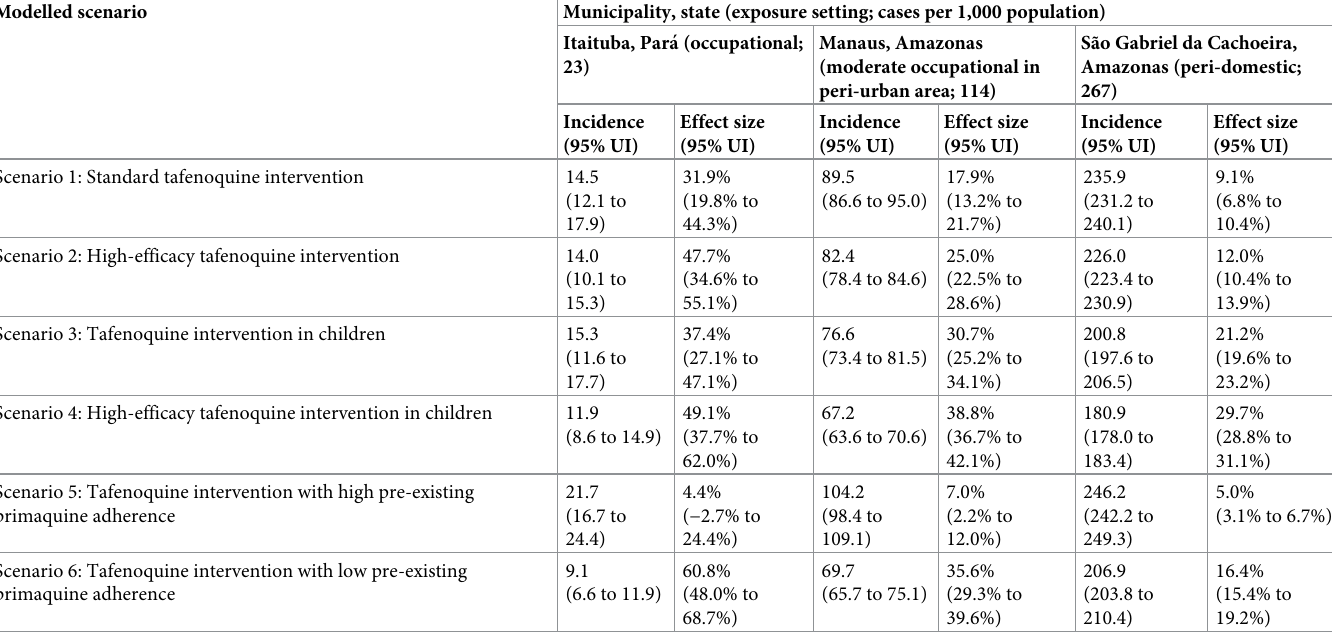
Table 3. Effect of introducing tafenoquine on P . vivax incidence in low-, moderate-, and high-transmission settings for scenarios 1–6. Modelled